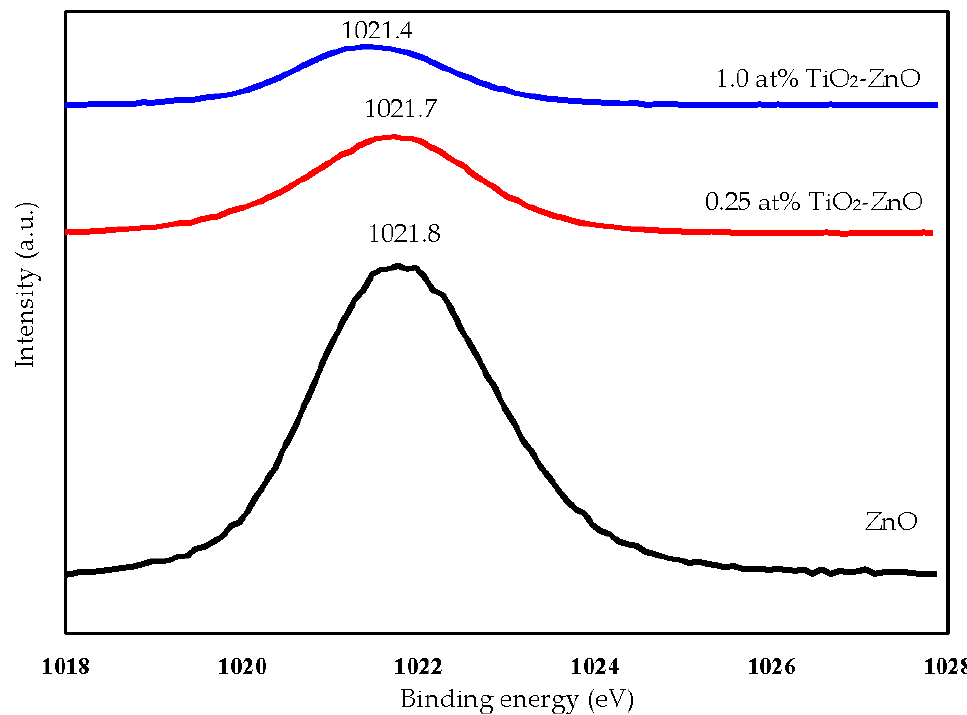
Figure 6. XPS spectra Zn2p of ZnO, 0.25 at % TiO 2 -ZnO, and 1.0 at % TiO 2 -ZnO.